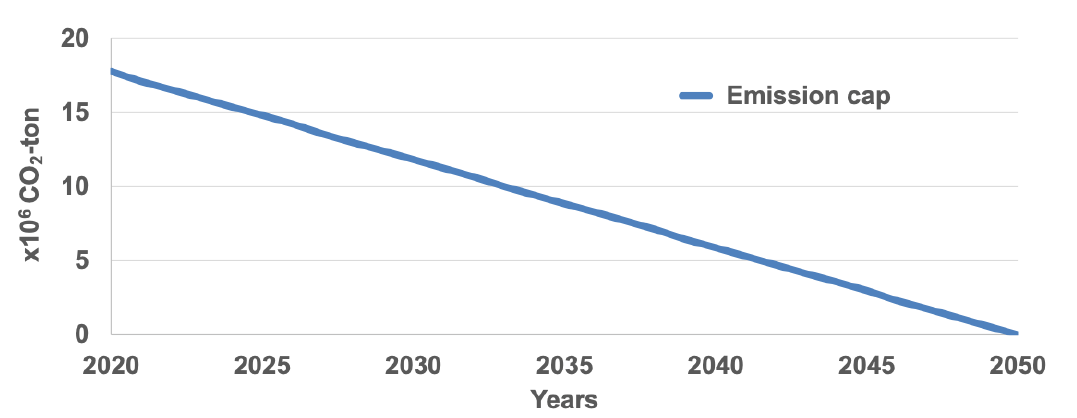
Figure 9. The emission allowance during the simulation period.